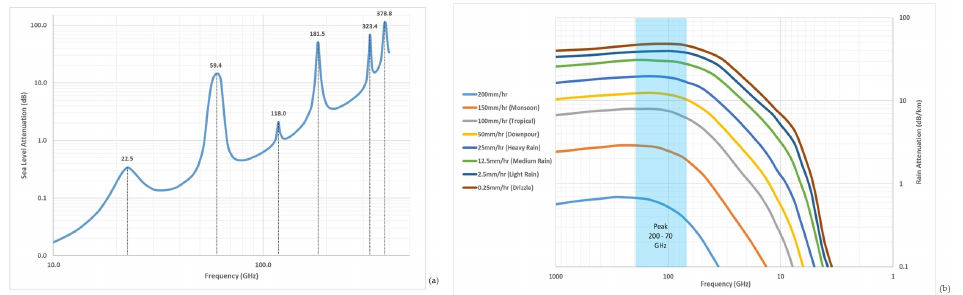
Figure 1. ( a ) Rain attenuation and ( b ) atmospheric and molecular absorption